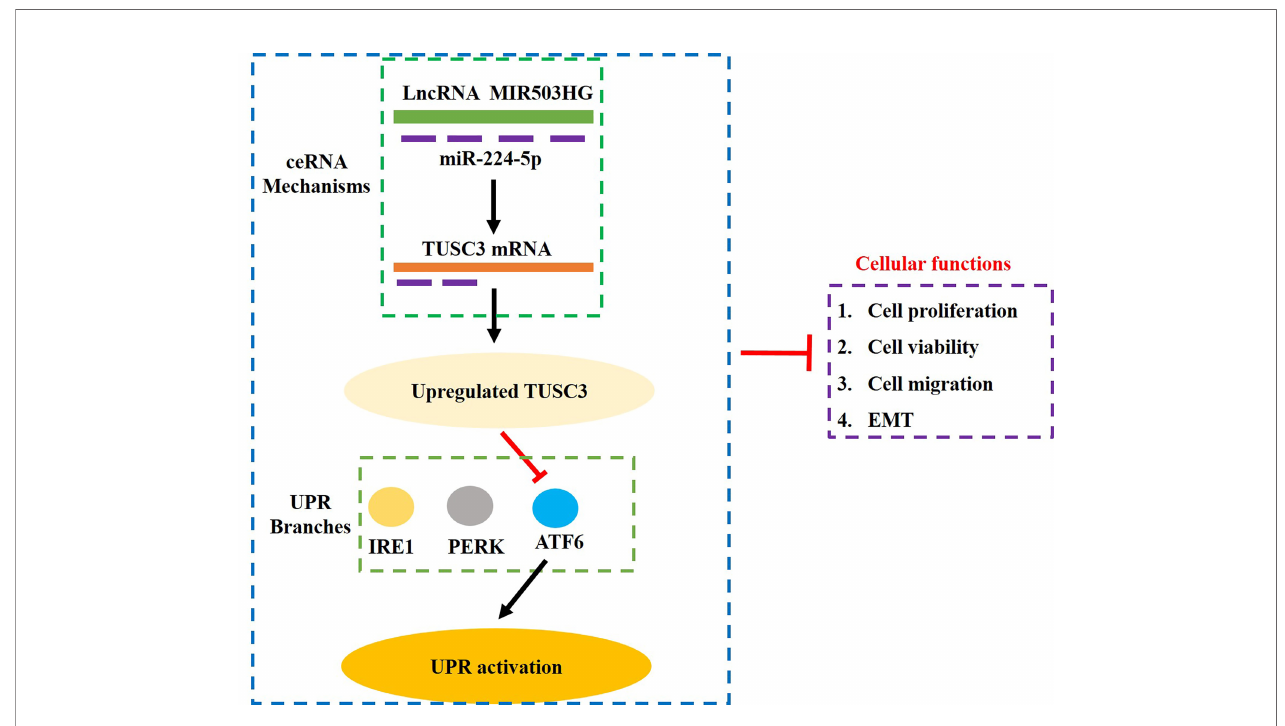
FIGURE 6 | The graphical abstract of this study. Brie fl y, overexpression of LncRNA MIR503HG sponged miR-224-5p to upregulate TUSC3, which further speci fi cally inactivated the ATF6 branch of UPR, resulting in the inhibition of proliferation, viability, Invasion and EMT in GC